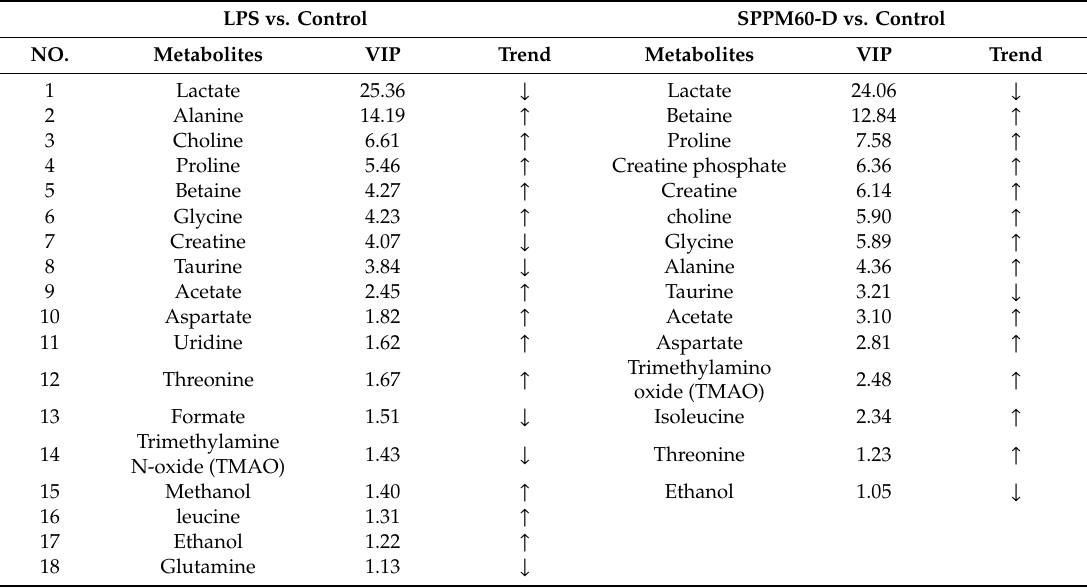
Figure 8. S-Plot of OPLS-DA analysis of RAW264.7 cells from treatment and control groups. ( A ) LPS and control groups ( B ) SPPM60-Dand control groups. Table 2. Identified differential metabolites.